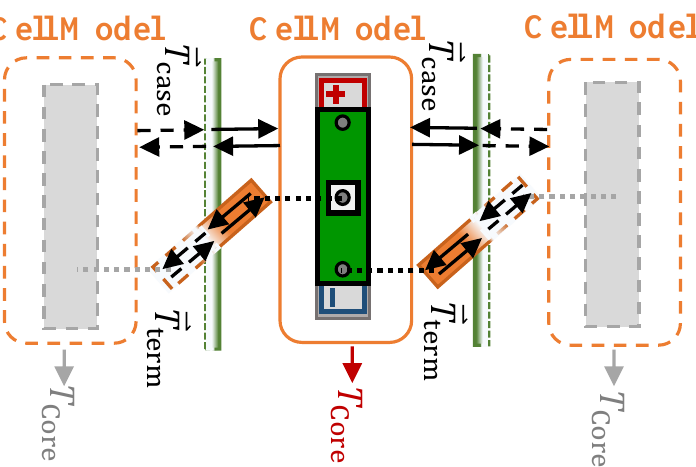
Figure 5. System simulation approach based on thermal coupling of multiple cell models via busbar and casing